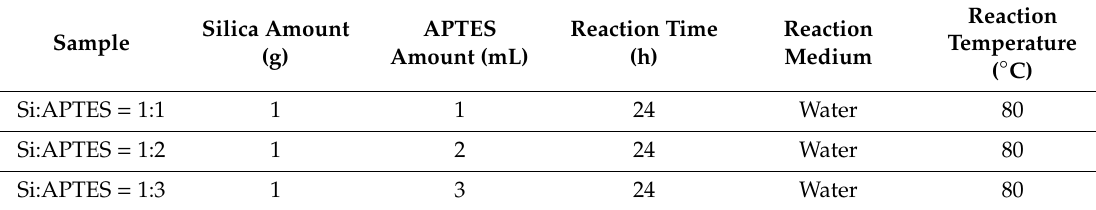
Table 3. The reaction conditions of silica functionalization with three di ff erent APTES